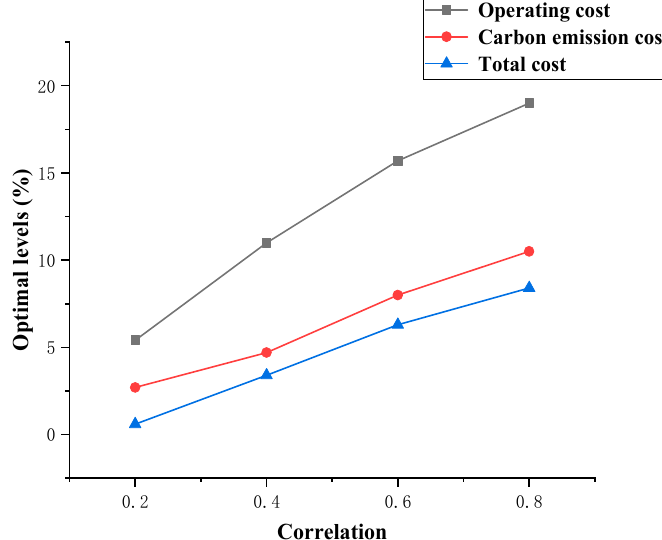
Figure 12. Optimization levels under different correlations.